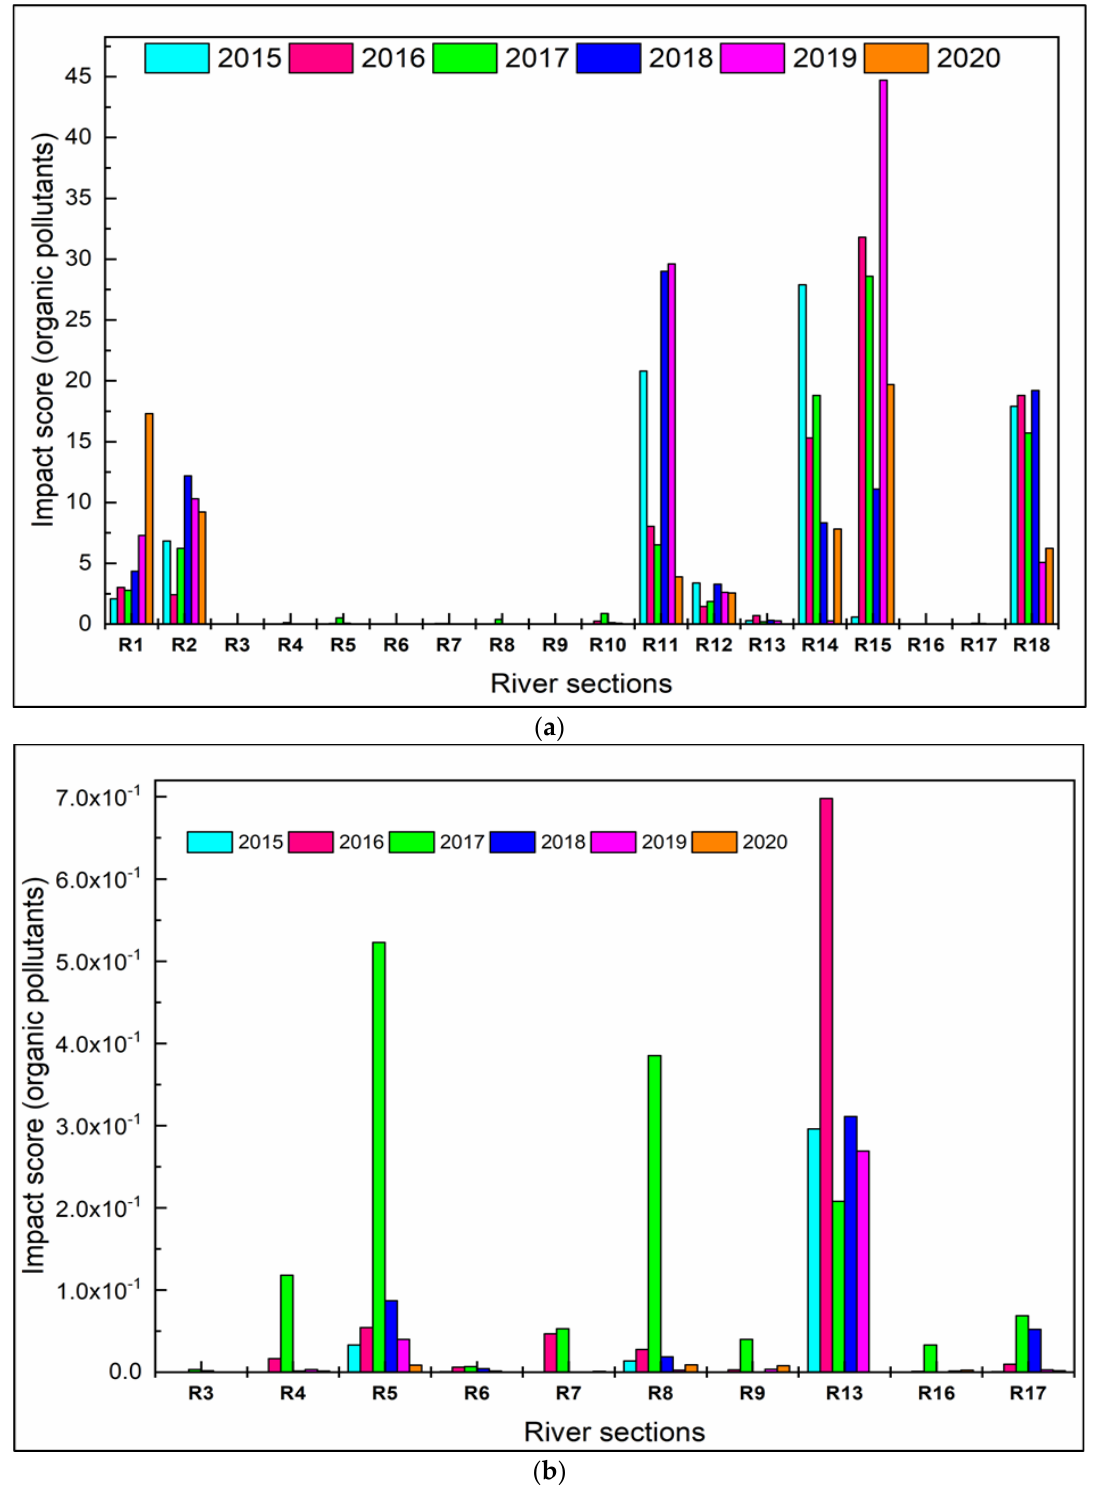
Figure 4. Non-carcinogenic impact score for organic pollutants (2015–2020): ( a ) R1-R18 sections on the original scale; ( b ) a deeper view of elected sections (R3, R6, R7, R9, R13, R16, R17).